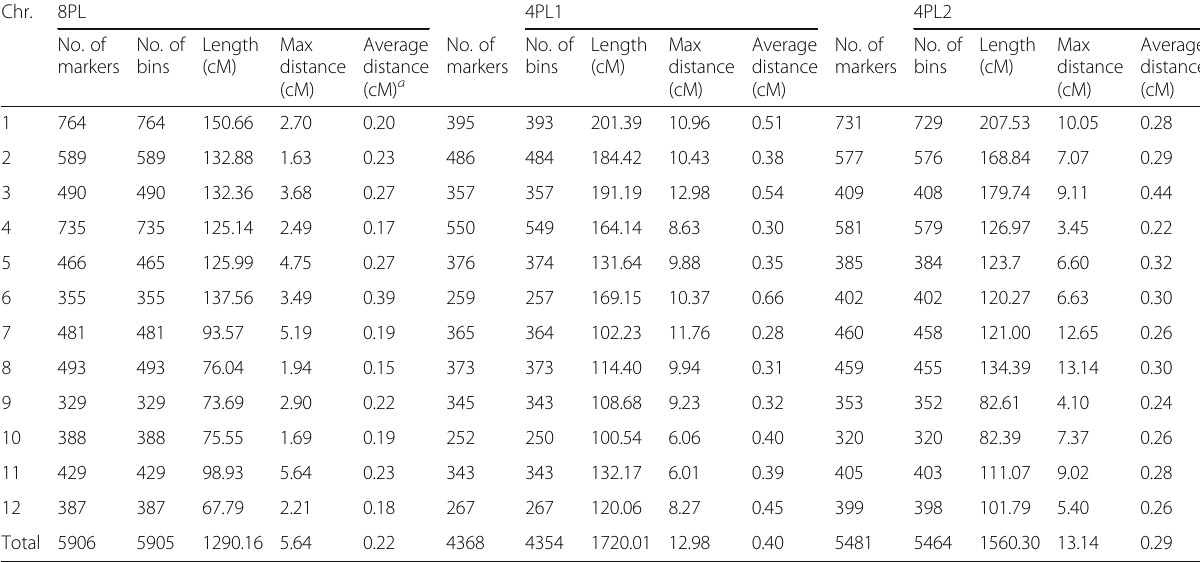
Table 1 Information on individual linkage maps for the three multi-parent RIL populations Chr. 8PL 4PL1 4PL2 No. of No. of markers